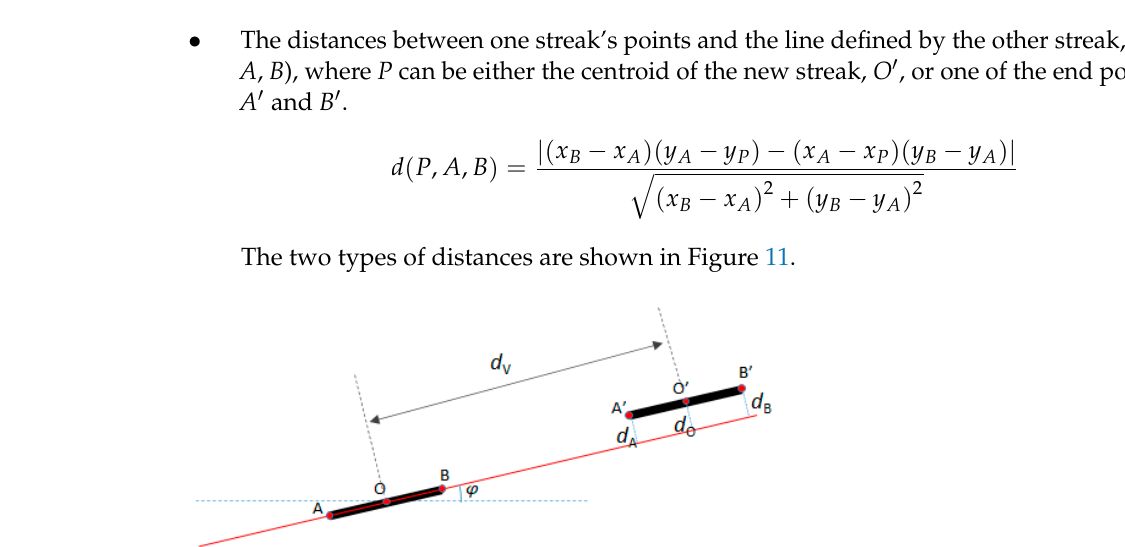
Figure 11. Computing distances between two streaks.